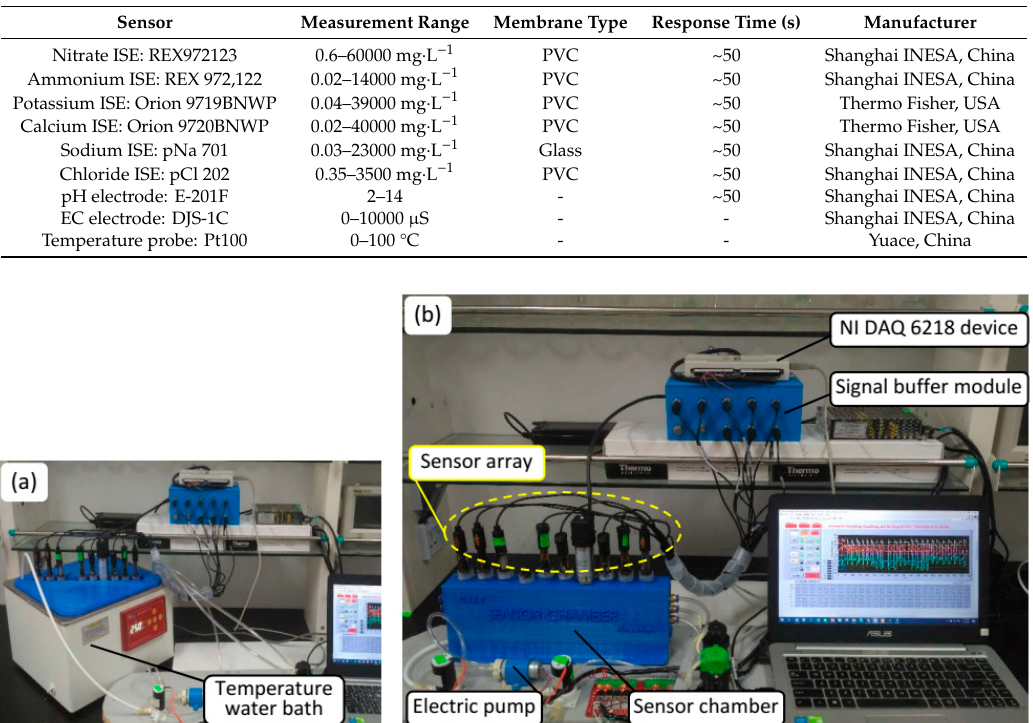
Table 1. Characteristics of the ion-selective electrodes (ISEs) and other sensors used in the study.